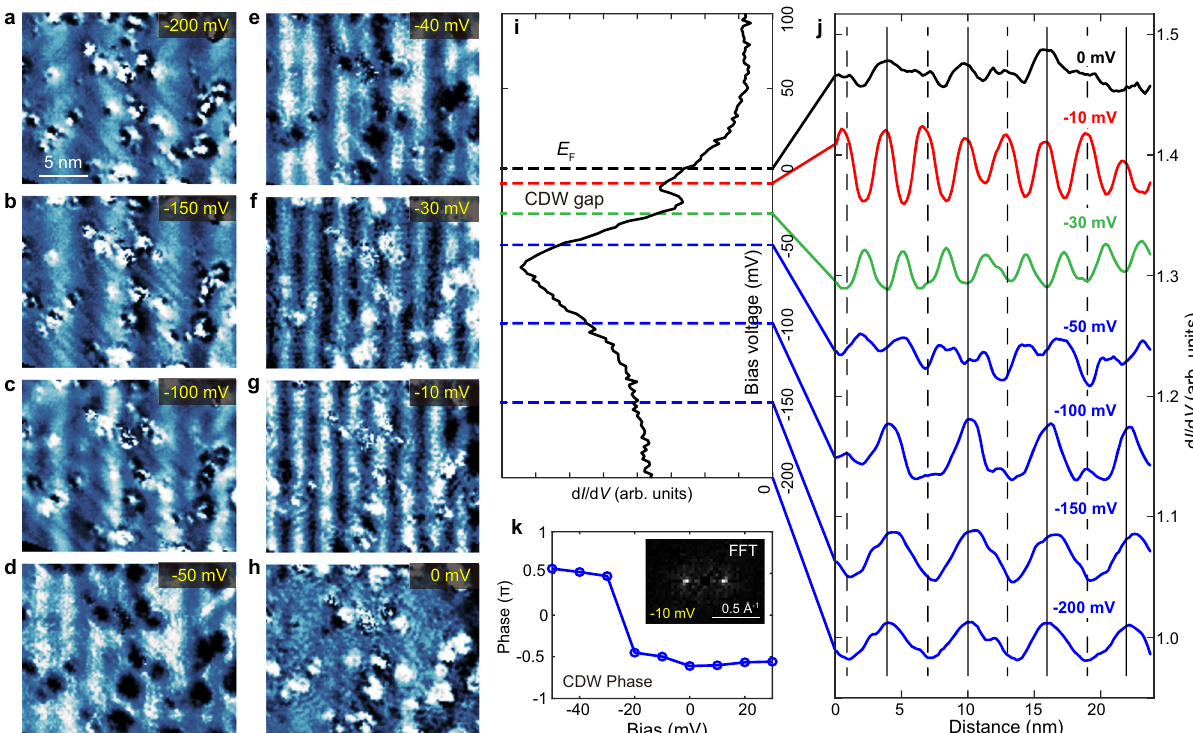
Fig. 4 Evolvement of SDW/CDW modulations with energy, and the phase inversion of CDW. a – h d I /d V maps taken by Cr-coated tip at various V b . The mapping area are the same for these panels. i The typical d I /d V point spectrum taken in this region (setpoint: V b = − 500 mV, I = 60 pA, Δ V = 10 mV). j Averaged line pro fi le of the d I /d V maps. An abrupt phase inversion can be seen between V b = − 30 and − 10 mV, which corresponds to the DOS dip region in i . k The phase of the CDW modulation, which are extracted from the raw FFT values at Q CDW . Inset image shows the FFT of g ( V b = − 10 mV) which displays Q CDW spots at ±2 π / λ CDW .